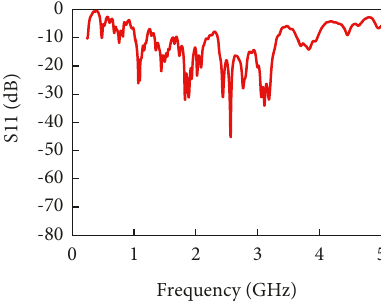
Figure 24: Measurement result of the S system